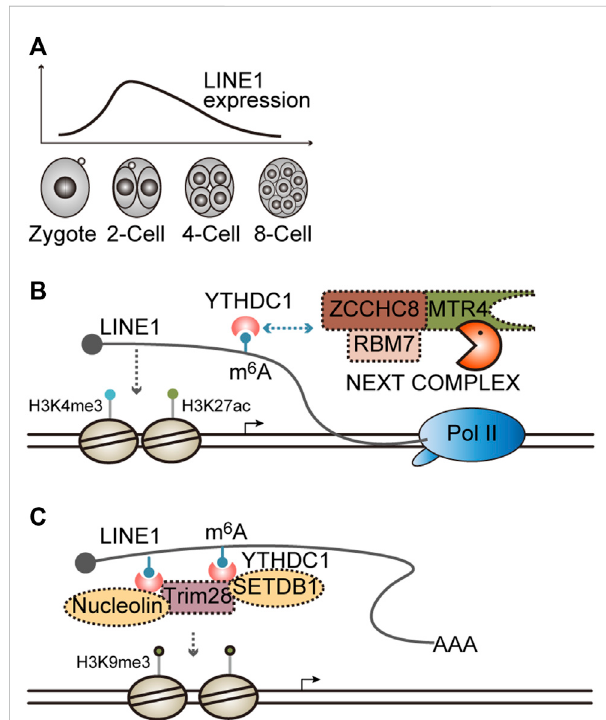
FIGURE 4 Functions and the degradation of LINE1 RNA. (A) Dynamic expression of LINE1 in mouse preimplantation embryos. LINE1, long interspersed nuclear element. (B) LINE1 RNA promotes an open chromatinstateandisregulatedbytheNEXTcomplex.LINE1can recruit histone modi fi ers that install activation marks H3K4me3/ H3K27ac. LINE1 is modi fi ed by m 6 A modi fi cation and can be recognized by the m 6 A modi fi cation reader YTHDC1, which in turn recruits the NEXT complex to facilitate the decay of LINE1. m 6 A, N6- methyladenosine; NEXT, nuclear exosome targeting complex, is an adapter for RNA exosome. (C) LINE1 RNA facilitates the formation of a close chromatin state. LINE1 is modi fi ed by m 6 A modi fi cation and can be recognized by m 6 A modi fi cation reader YTHDC1, which in